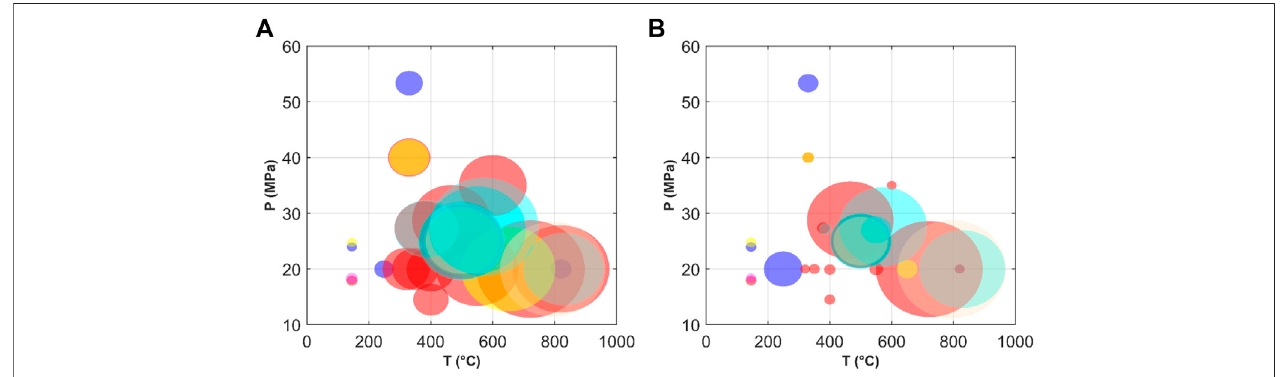
FIGURE 4 | Boundary conditions of single- fl ow sCO 2 cycles as a function of the maximum operation temperature and pressure: (A) Thermal ef fi ciency; (B) Net poweroutput(legend: simple recuperation intercooling reheating inter-recuperation pre-compression splitexpansion